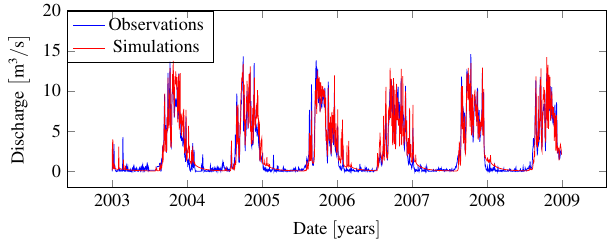
Figure 8. Simulation results compared to the observations for the validation period from 1 October 2003 to 1 October